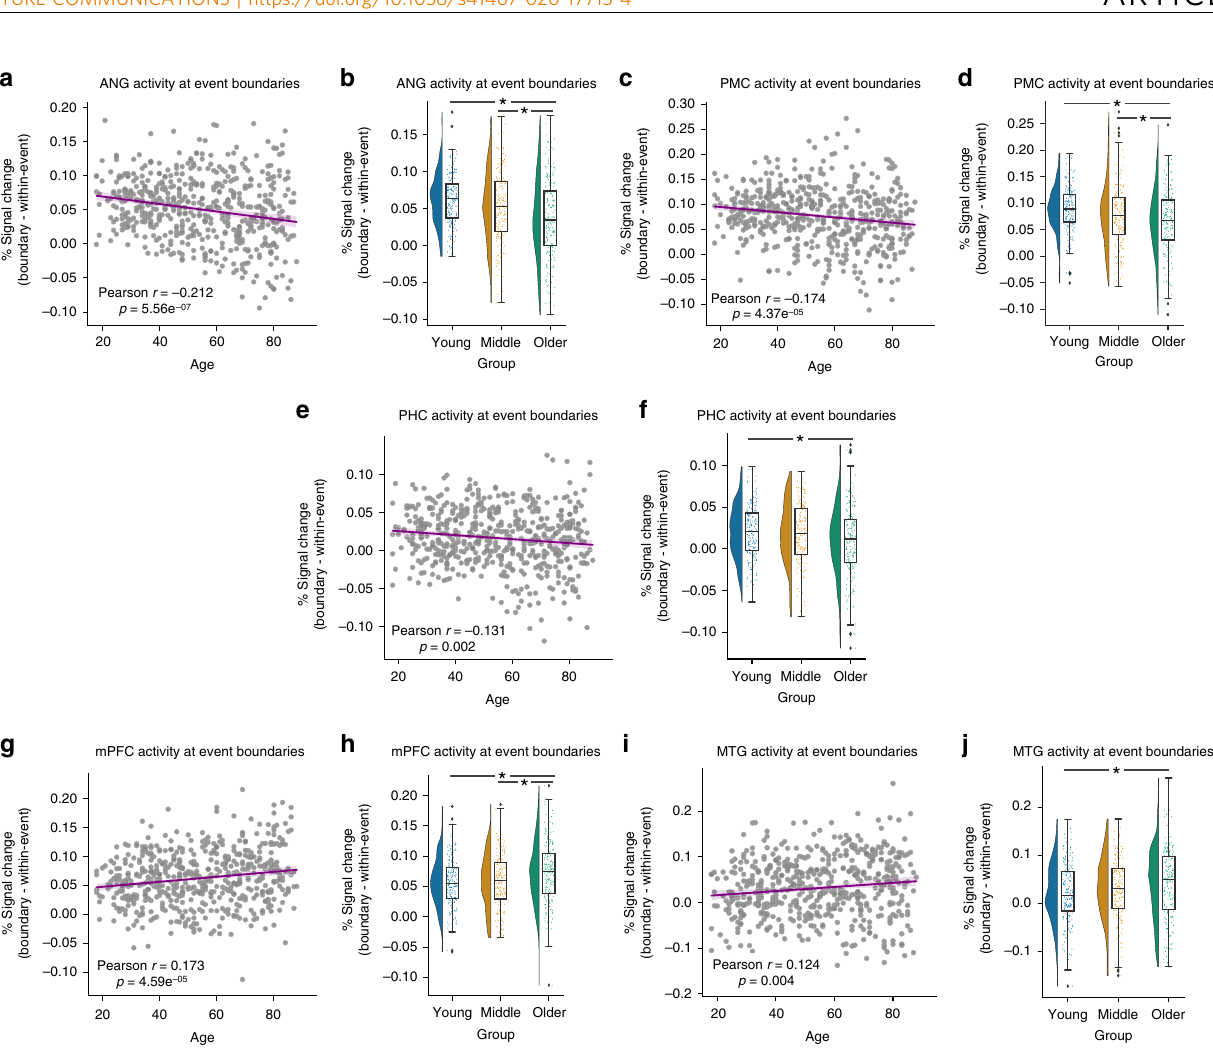
Fig. 5 Declines and increases in boundary-evoked activity in the Posterior Medial network. Age-related declines in boundary-evoked responses in angular gyrus ( a ), b , posterior medial cortex c , d , and parahippocampal cortex e , f . Age-related increases in boundary-evoked responses in medial prefrontal cortex g , h and middle temporal gyrus i , j . (Correlations were assessed via Person ’ s r . * indicates a signi fi cant difference via Tukey ’ s HSD at p < 0.05 corrected following a one-way ANOVA. Raincloud plots depict data distributions across groups, with box components displaying median values and data quartiles. N = 546 for correlations, N = 182 per group for groupwise comparisons, examined over a single